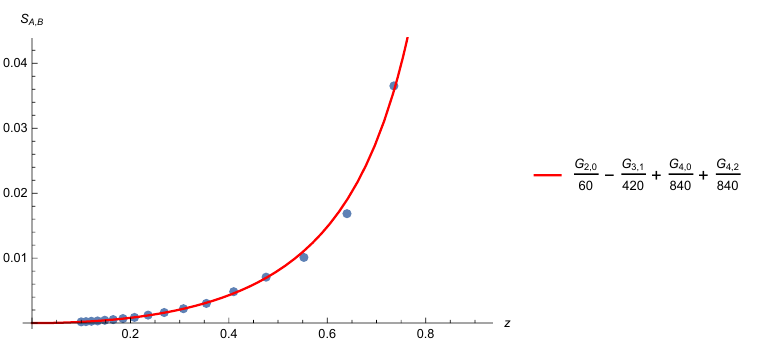
Figure 4 . Mutual information of two balls for 4 d free boson (0 < z < 0 : 8).